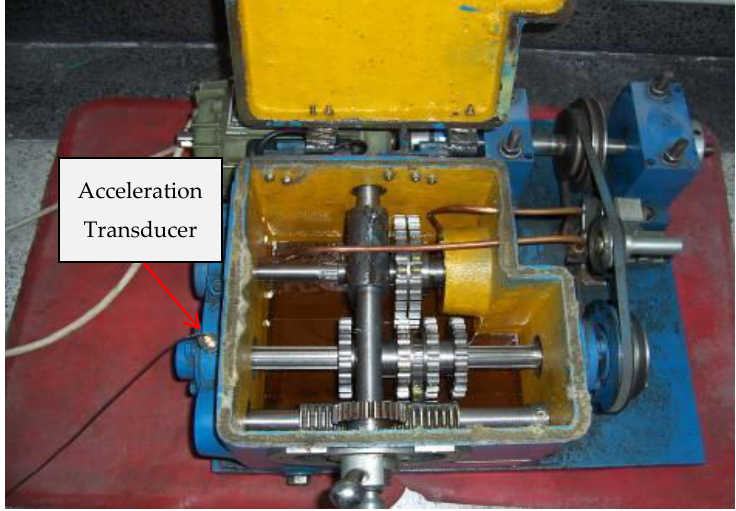
Figure 2. The test rig of faulty gear.